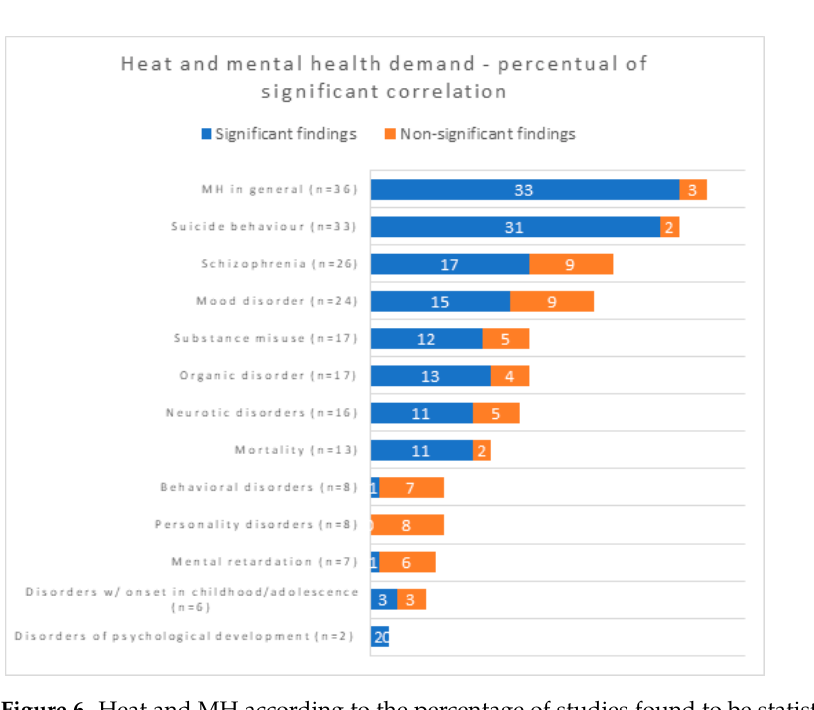
Figure 6. Heat and MH according to the percentage of studies found to be statistically significant (CI 95%). (CI